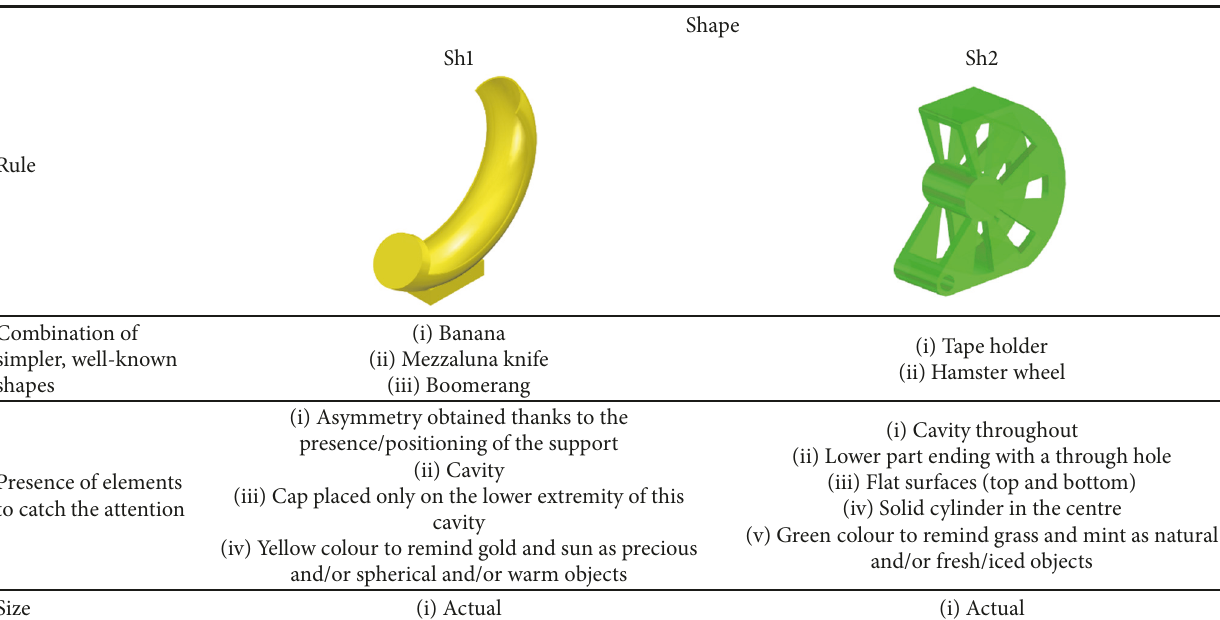
Table 1: Characteristics of the two shapes used for the